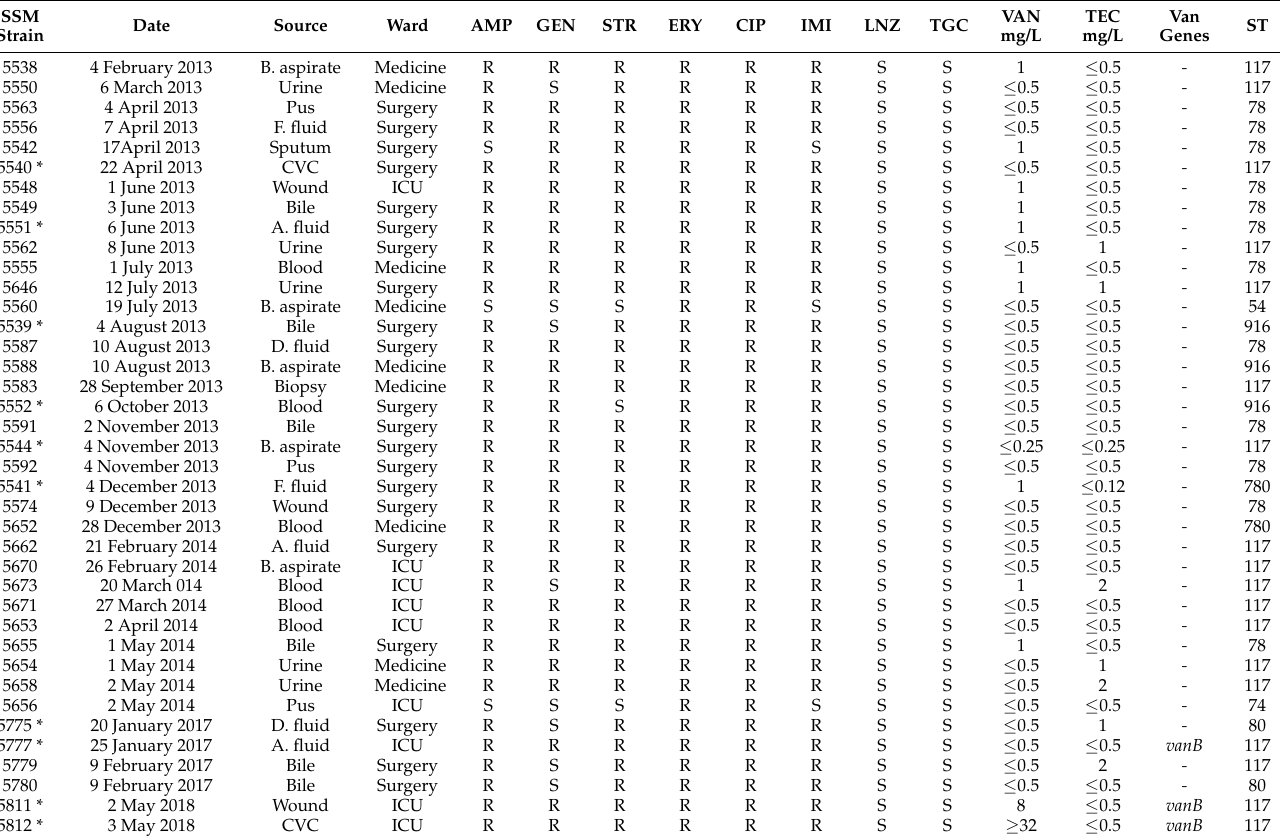
Table 1. Characteristics of E. faecium